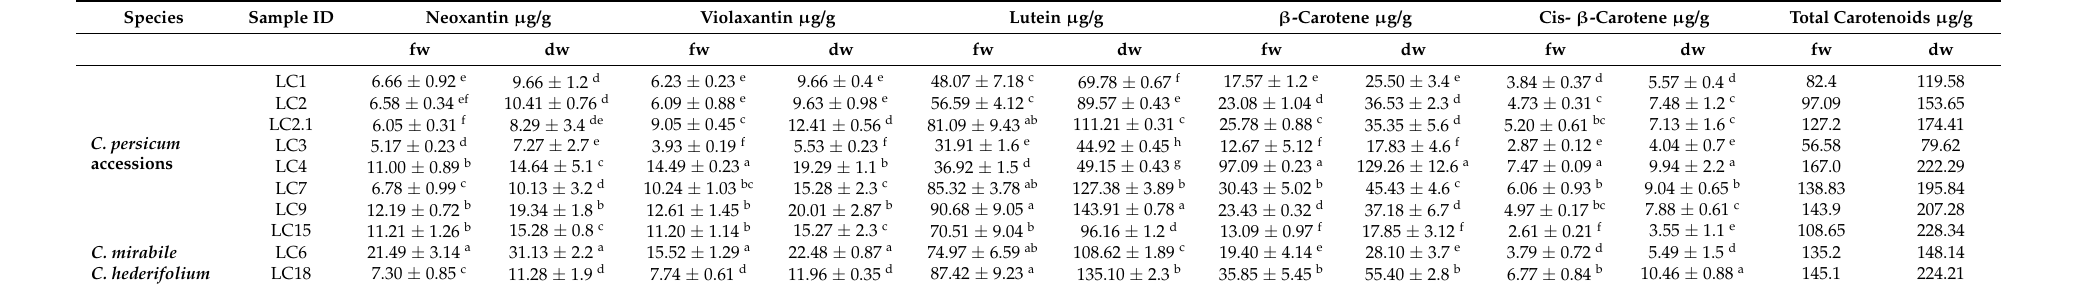
Table 2. Carotenoids composition ( µ g/g fresh (fw) and dry weight (dw) ± SD) in Cyclamen genotypes